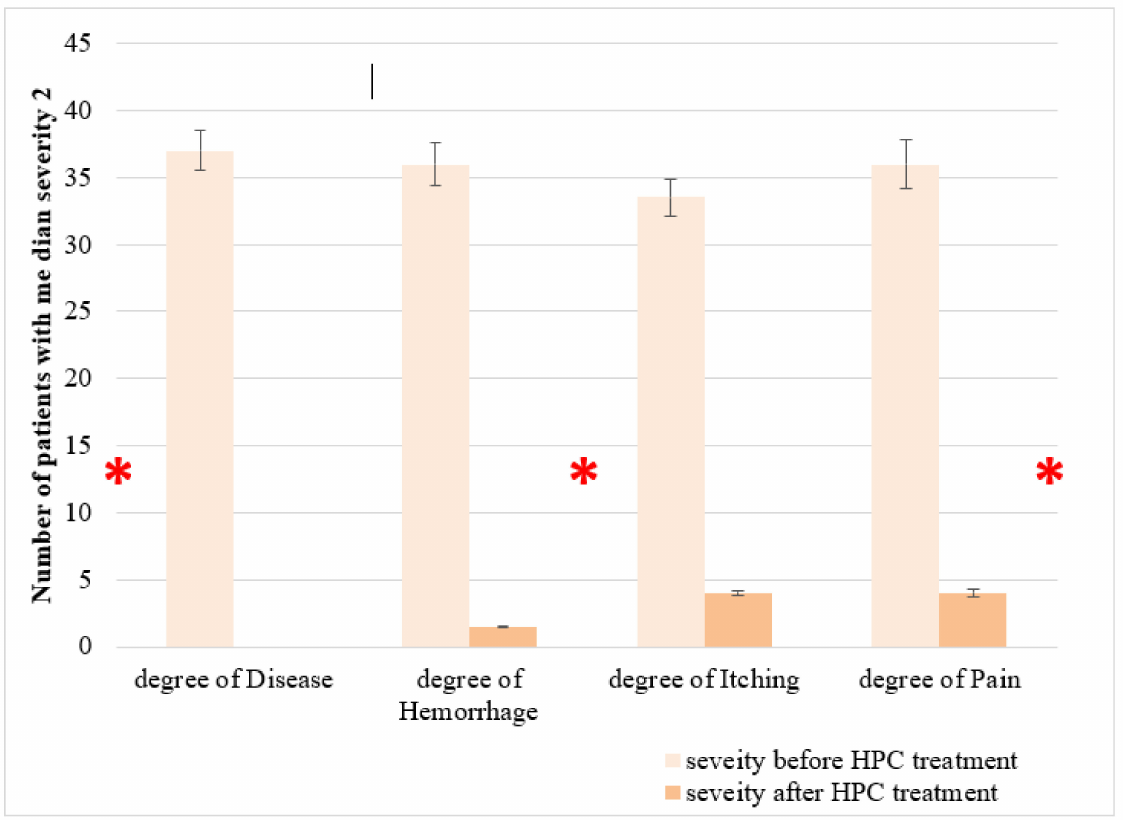
Figure 6. Effect of anti-hemorrhoidal polyherbal cream (HPC) on severity of hemorrhoids. The efficacy of HPC in the treatment of hemorrhoids was evaluated in an open label, non-randomized, uncontrolled clinical study. This clinical study was carried out on 37 patients (17 females and 20 males, ages 19–59). Values represent the number of patients with median severity 2. * p < 0.01—significant as compared with